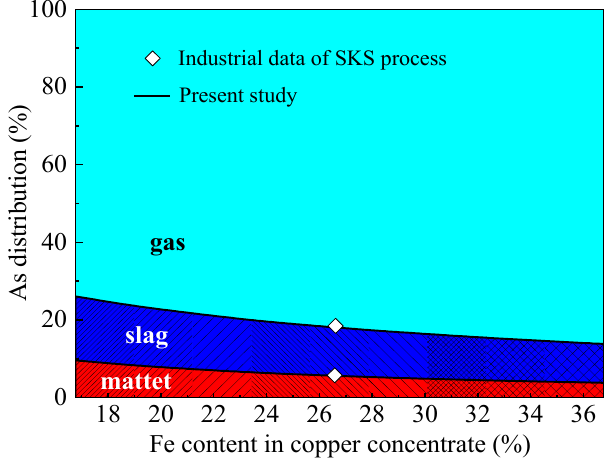
Figure 2. Comparison between the actual production and simulation results of the effect of Fe content in concentrate on the distribution of arsenic among the gas, slag and matte.